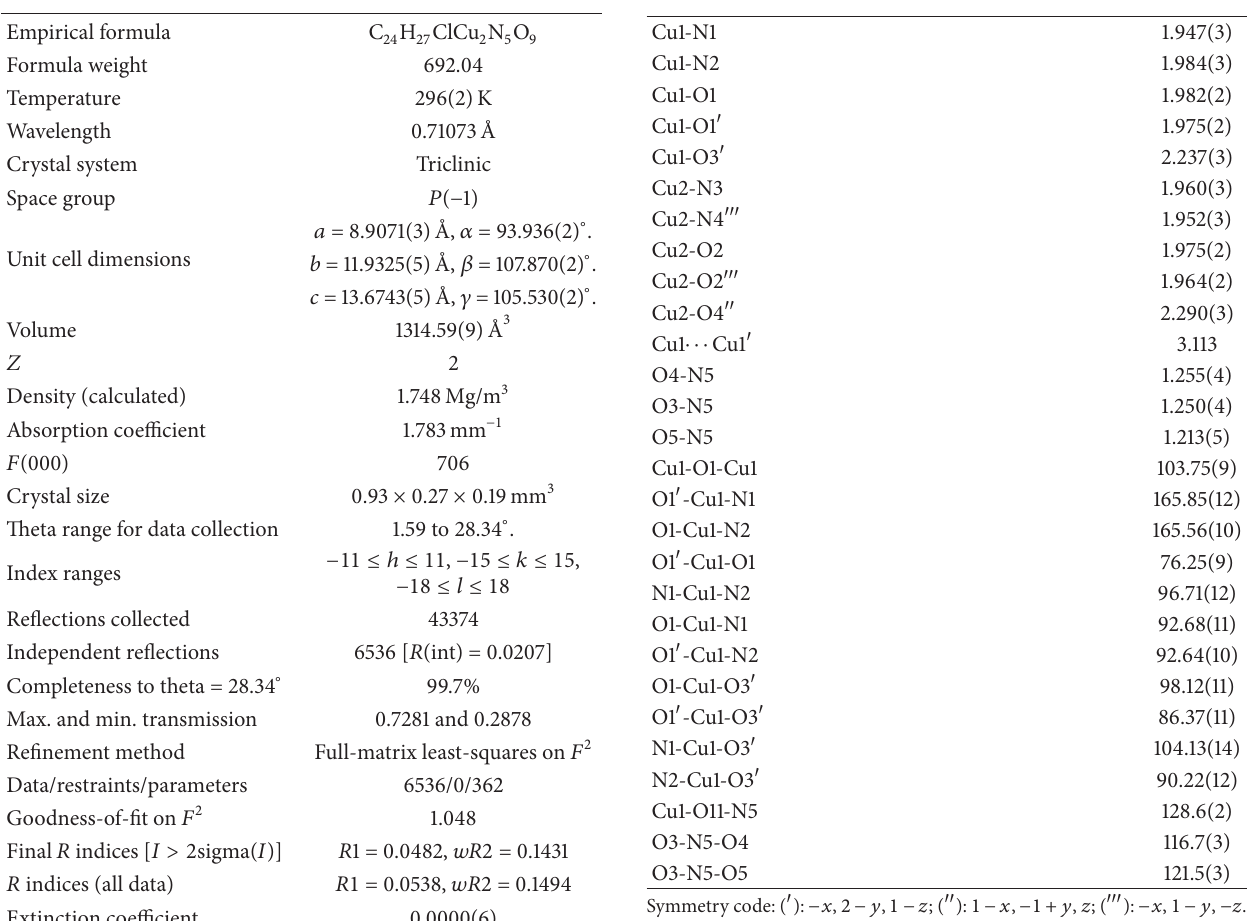
Table 1: Crystal data and structure refinement for [ { Cu 2 (tidf)( 𝜇 - NO 3 ) } ∞ ]ClO 4 .